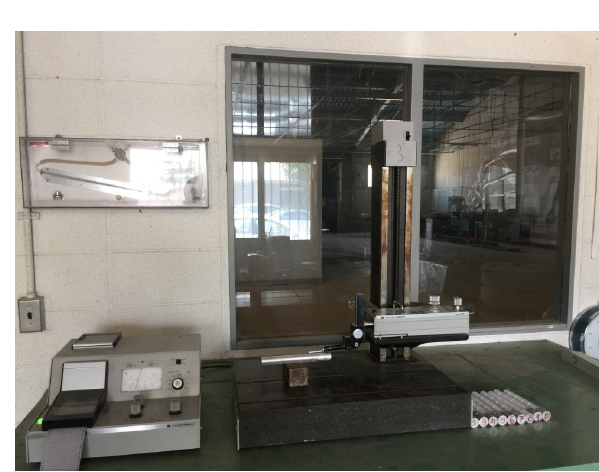
Figure 4: A TYLOR-HOBSON (10) surface roughness